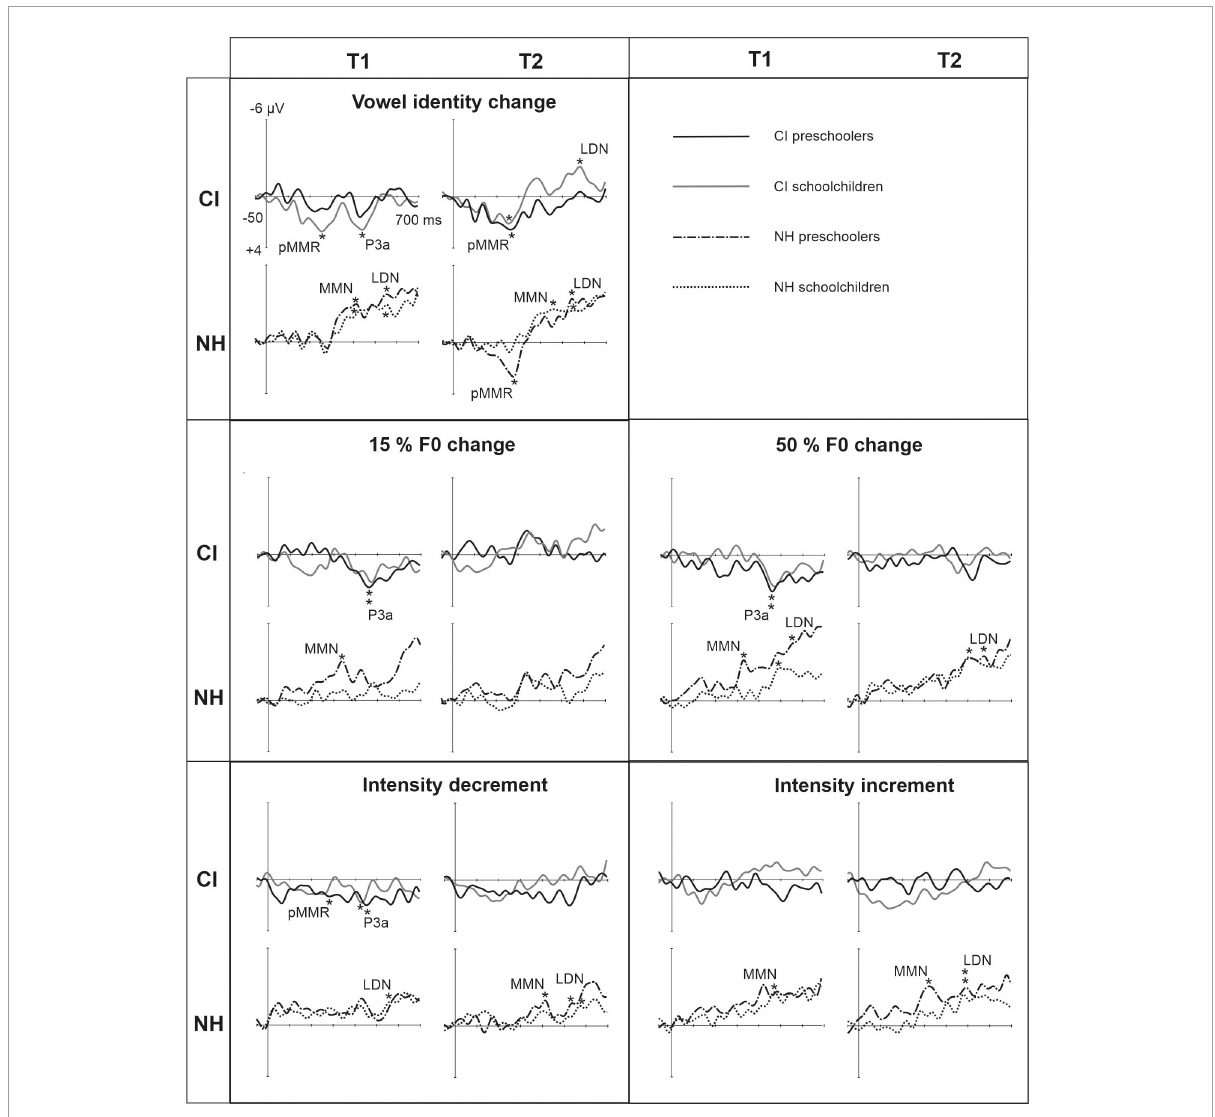
FIGURE3 Difference waveforms (ERPs of deviant minus standard) from the six-electrode ROI (F3, Fz, F4, C3, Cz, C4) for the difficult-to-detect change types of vowel identity, F0 and intensity changes at measurement time points T1 and T2 for the preschoolers (age below 6 years 9 months) and schoolchildren (age above 6 years and 9 months) with CI and NH. The data is referenced to the nose. Significant responses are marked with an asterisk. ERP, event related potentials; CI, children with cochlear implants; NH, normally hearing children; pMMR, positive mismatch response; MMN, mismatch negativity; P3a, positive ERP following MMN; LDN, late differentiating negativity; F0, fundamental